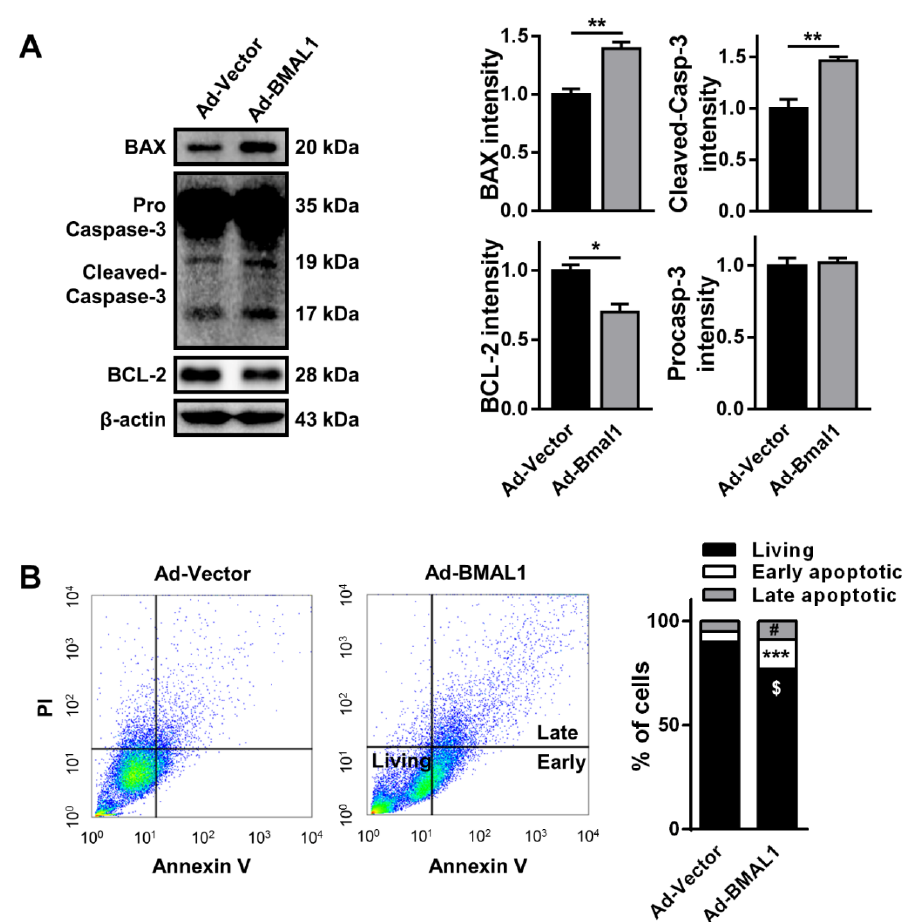
Figure 6. Apoptosis increases in Ad-BMAL1 virus-infected U87MG cells. ( A )The expression levels of BAX, pro-caspase-3, cleaved-caspase-3 (both 19 kDa and 17 kDa), and BCL-2 were measured with ImageJ, normalized with β -actin, and then expressed as a percentage of Ad-vector by Western